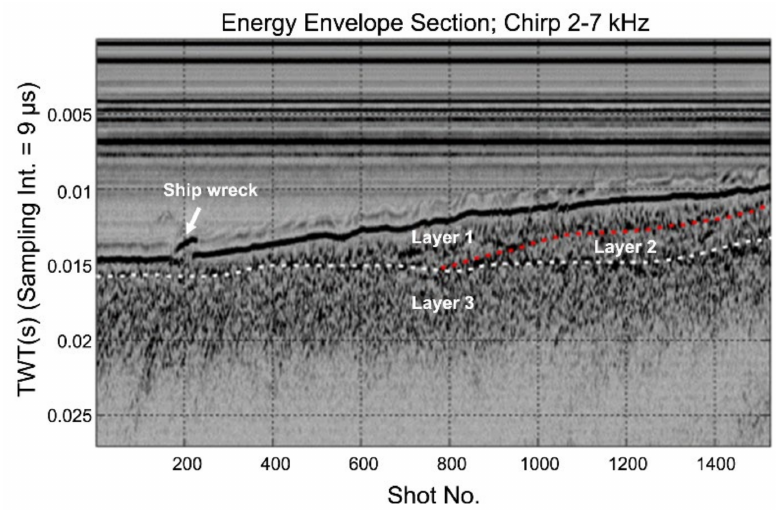
Figure 6. Chirp sub-bottom profiler (SBP) envelope